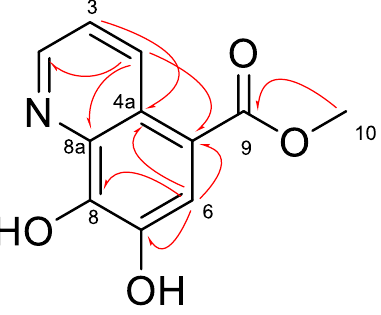
Figure 3. Selected HMBC correlations (H → C) of synthesized 1 .